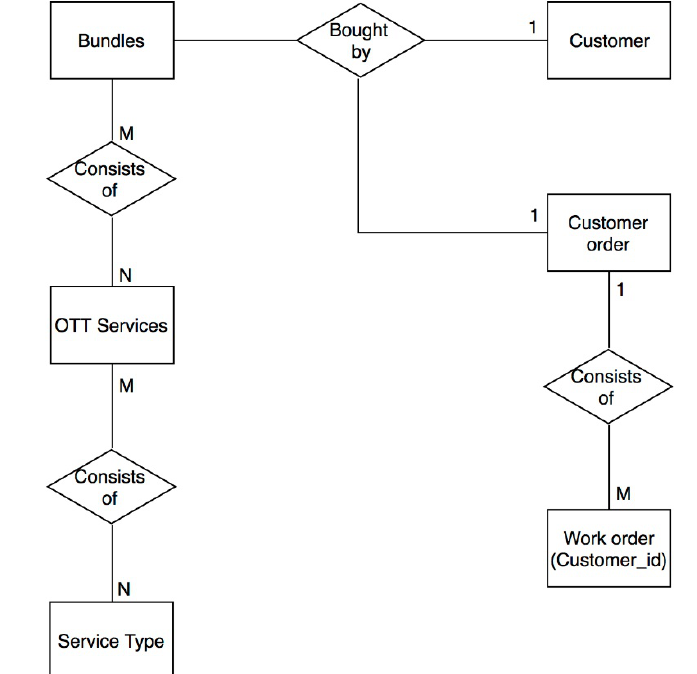
Figure 1. Flexible data structure for product definition and provisioning. Adapted from (Czarnecki and Dietze, 2017)